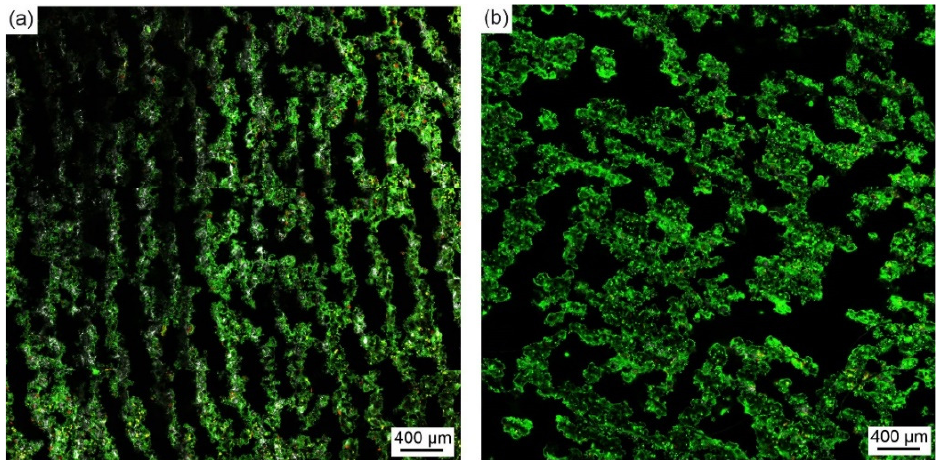
Figure 10. In vitro distribution of MCF-7 cell mass on the surface of porous NiTi-(Ar) ( a ) and NiTi-(N) ( b ) alloys obtained by the SHS.